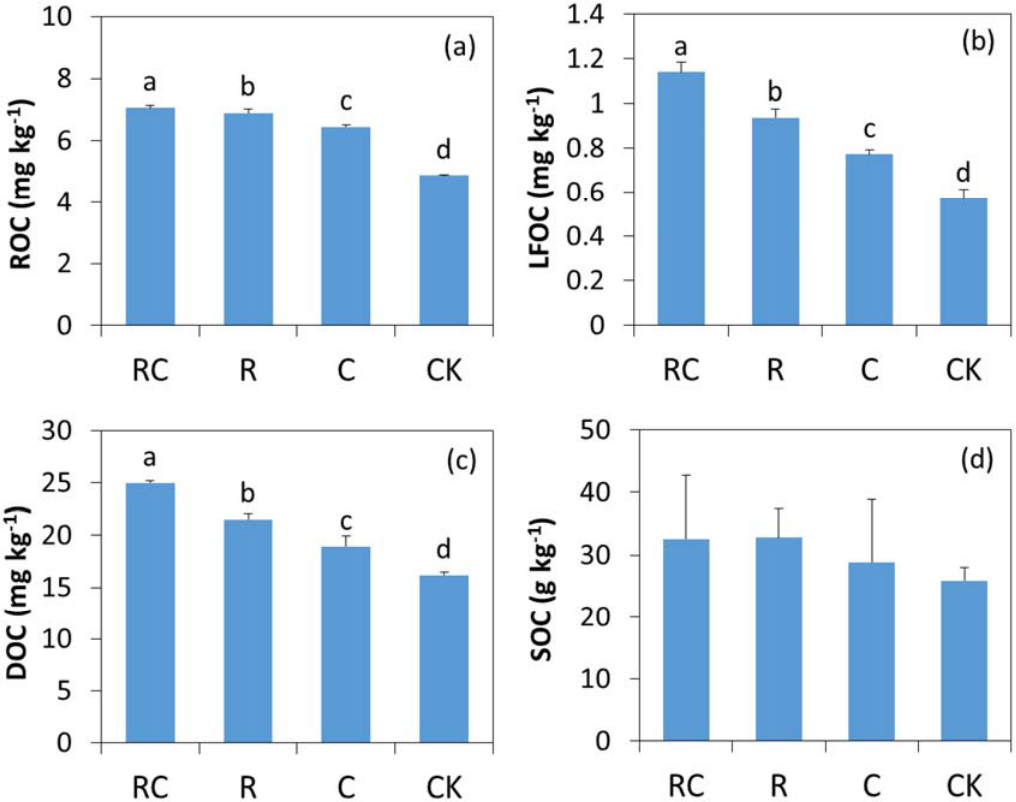
Figure 2. Soil readily oxidizable organic carbon (ROC, ( a )), light fraction organic carbon (LFOC, ( b )), dissolved organic carbon (DOC, ( c )), and soil organic carbon (SOC, ( d )) under mixed rice straw and biochar addition (RC), rice straw addition (R), biochar addition (C), and control (CK) conditions. Values are the means of three replicates ( ± SE). Different letters indicate significant differences among the means of the different treatments.